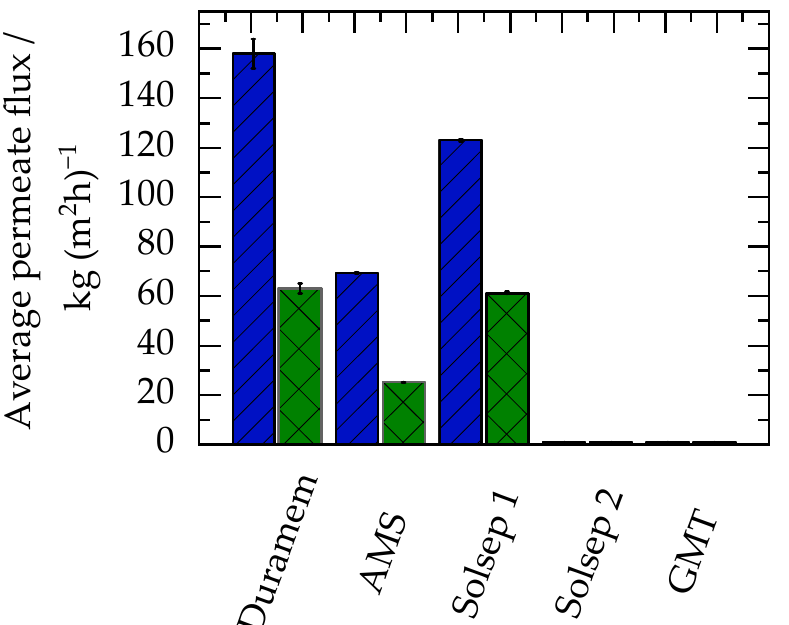
Figure 2. Average permeate flux for different OSN membranes at 30 bars and 25 ◦ C. The x-axis indicates the names of the membranes used in this study. Details of the membranes are shown in Table 2. Blue bars with a line pattern indicate permeate flux for the diafiltration with a feed of 100 wt% water, whereas green bars with a cross pattern represent permeate flux for the diafiltration with 10 wt% ethanol in the aqueous feed.